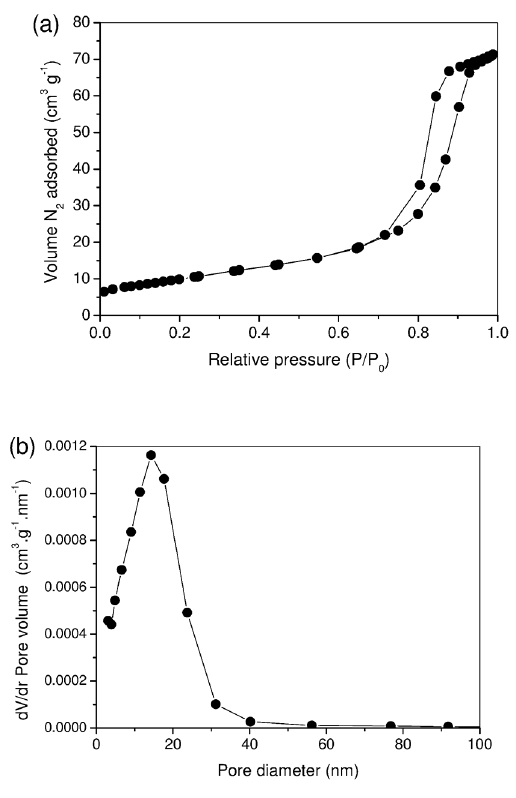
Figure 2: (a) Nitrogen adsorption–desorption isotherms and (b) pore size distribution curve of ZnWO physical characteristics regarding the pores structure are essential for immobilization purposes by adsorption process.